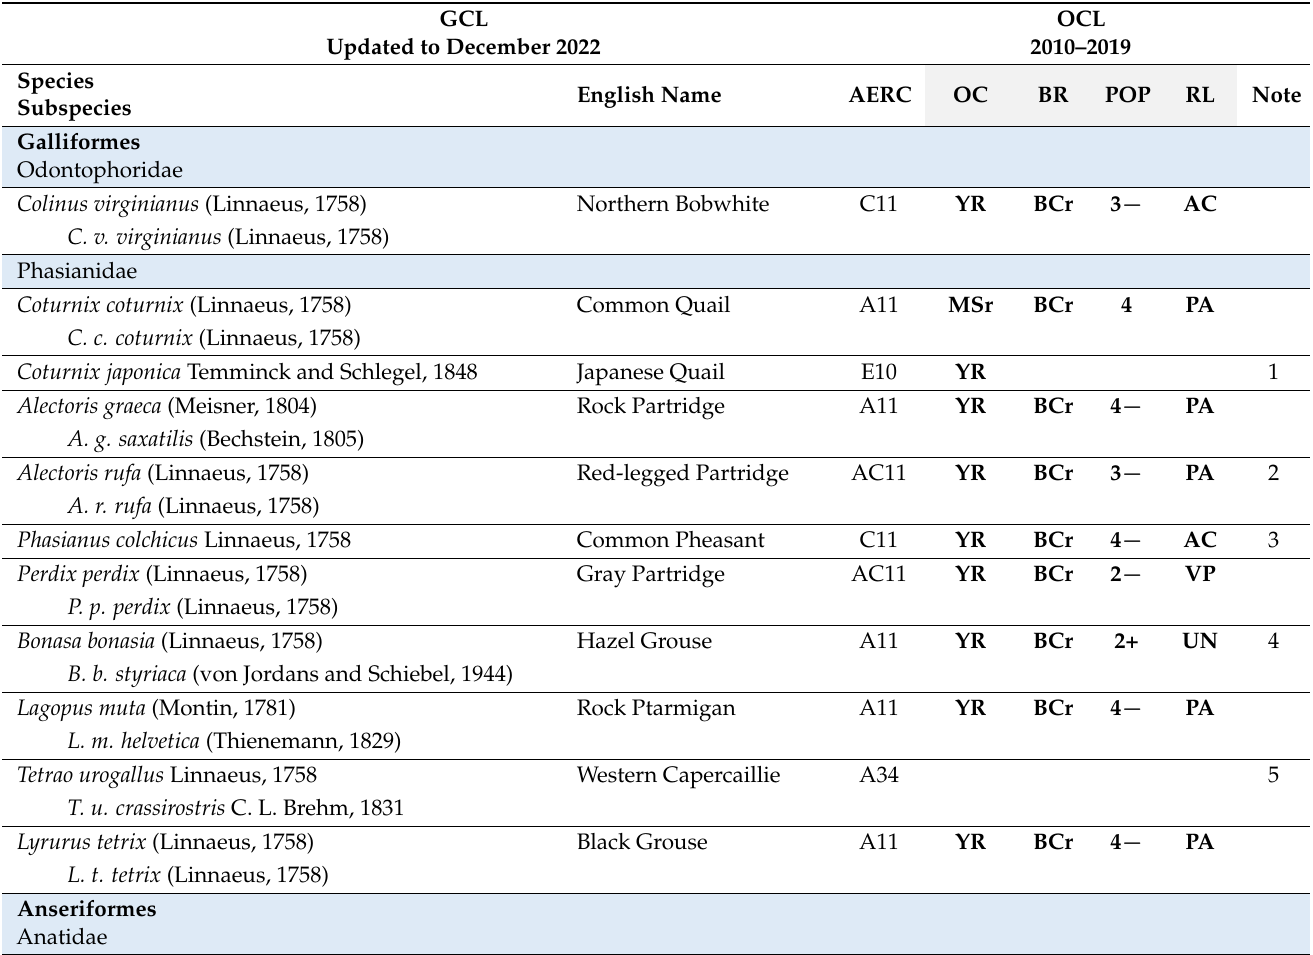
Table 5. The General Checklist (GCL), 1685–2022, and Operational Checklist (OCL), 2010–2019, for the birds of Piedmont and Aosta Valley (PAV). Additional information on the status of some species is reported in Section 3.1.1. Both the complete GCL and complete OCL can be found in the spreadsheet in the Supplementary